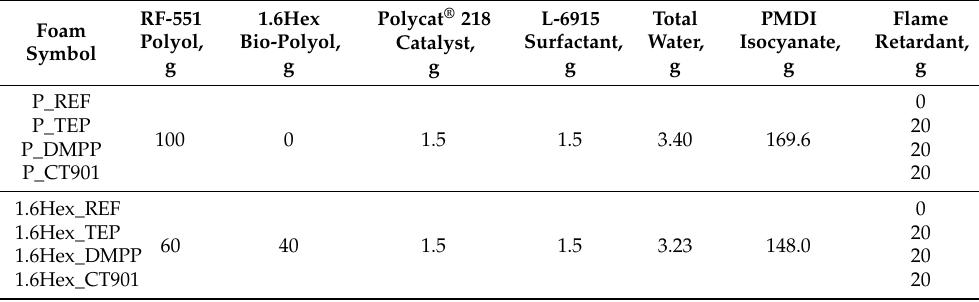
Table 1. Formulation of rigid polyurethane foams. Foam